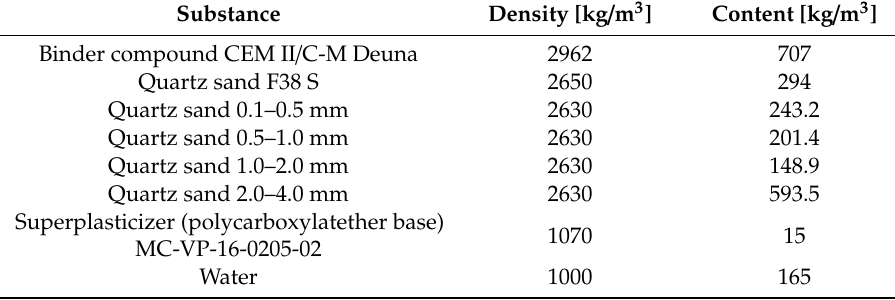
Table 2. Mix design of cementitious matrix for concrete HF-2-165-4 (mix design adapted from [44]).